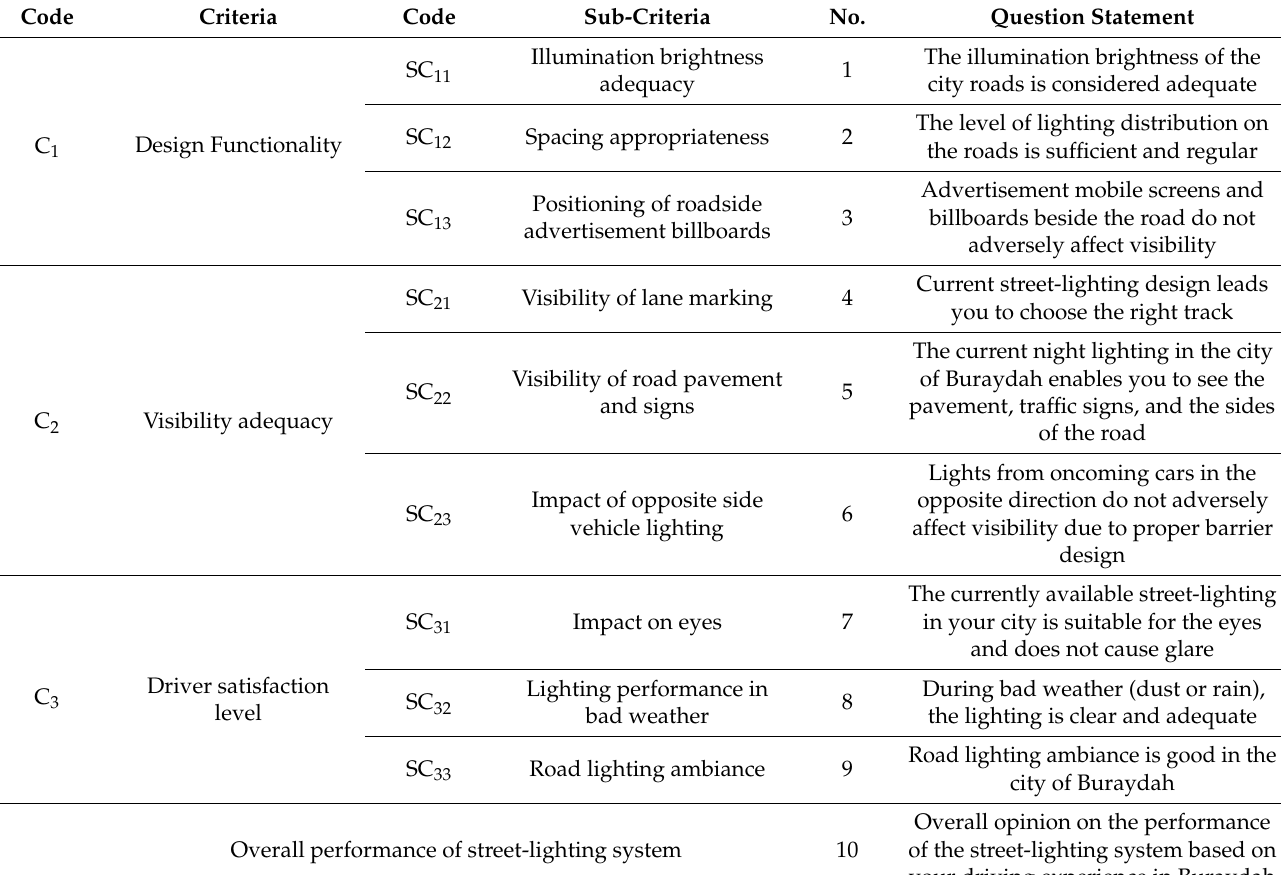
Table 1. Question statements and performance criteria for an urban street-lighting